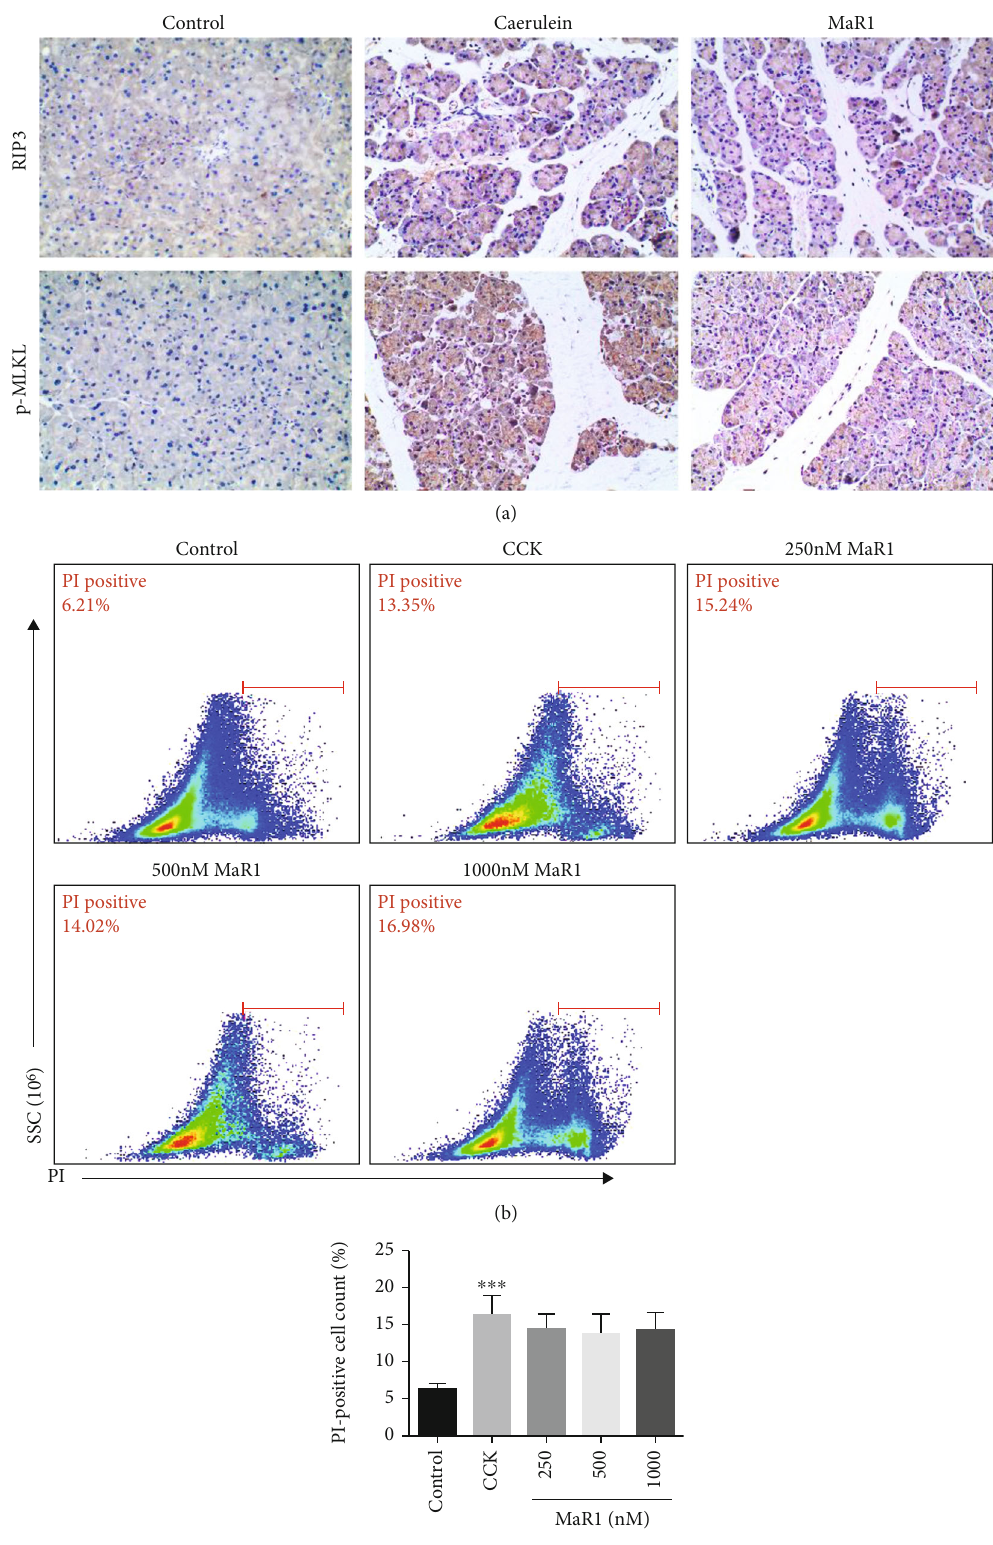
Figure 2: MaR1 showed protective e ff ects independent of pancreatic acinar cells. (a) IHC examinations for RIP3 and p-MLKL of the pancreas in magni fi cation 200x. n ≥ 6 each group. (b, c) Flow cytometry of PI staining for 266-6 cells and relative positive cell counting was quanti fi ed. ∗∗∗ P < 0 : 001 vs. the control group. n ≥ 9 each